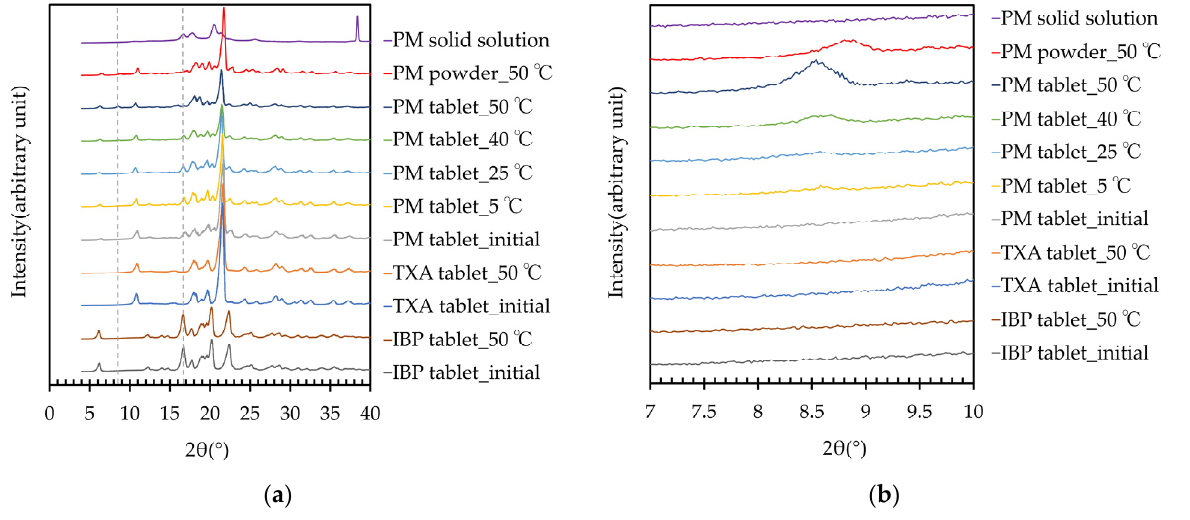
Figure 5. ( a ) PXRD patterns of IBP, TXA, and PM before and after storage for 2 months, and PM solid solution; ( b ) PXRD peaks of IBP, TXA, PM, and PM solid solution around 8.5°–8.8°, before and after storage for 60 days.